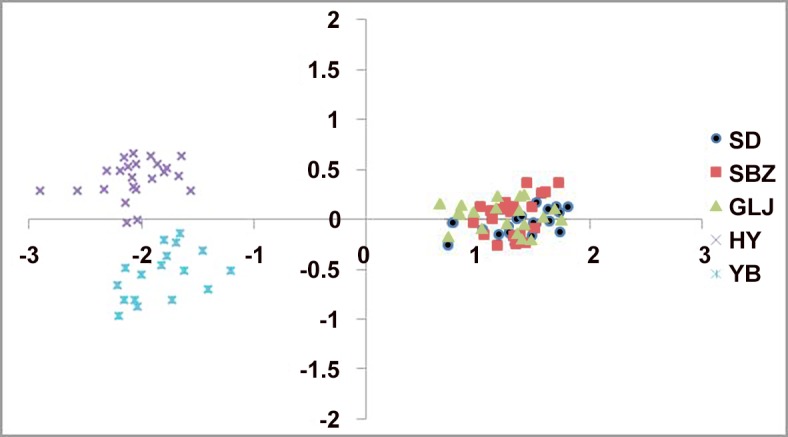
Principal coordinates analysis (PCO) of microsatellites from five populations and 100 individuals of C. multipinnata.